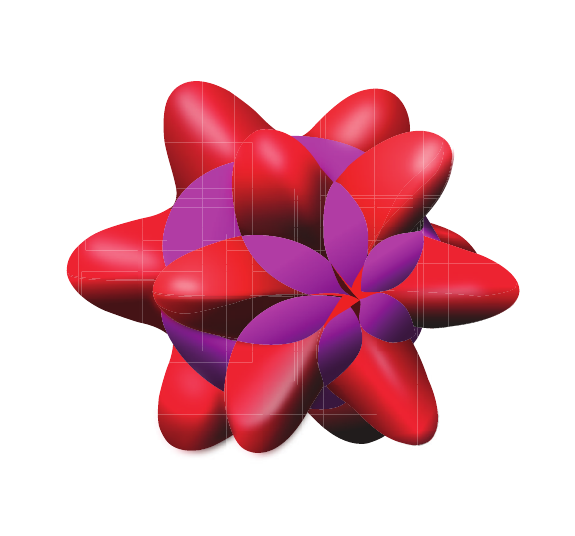
Figure 6: Generalized offset curve.